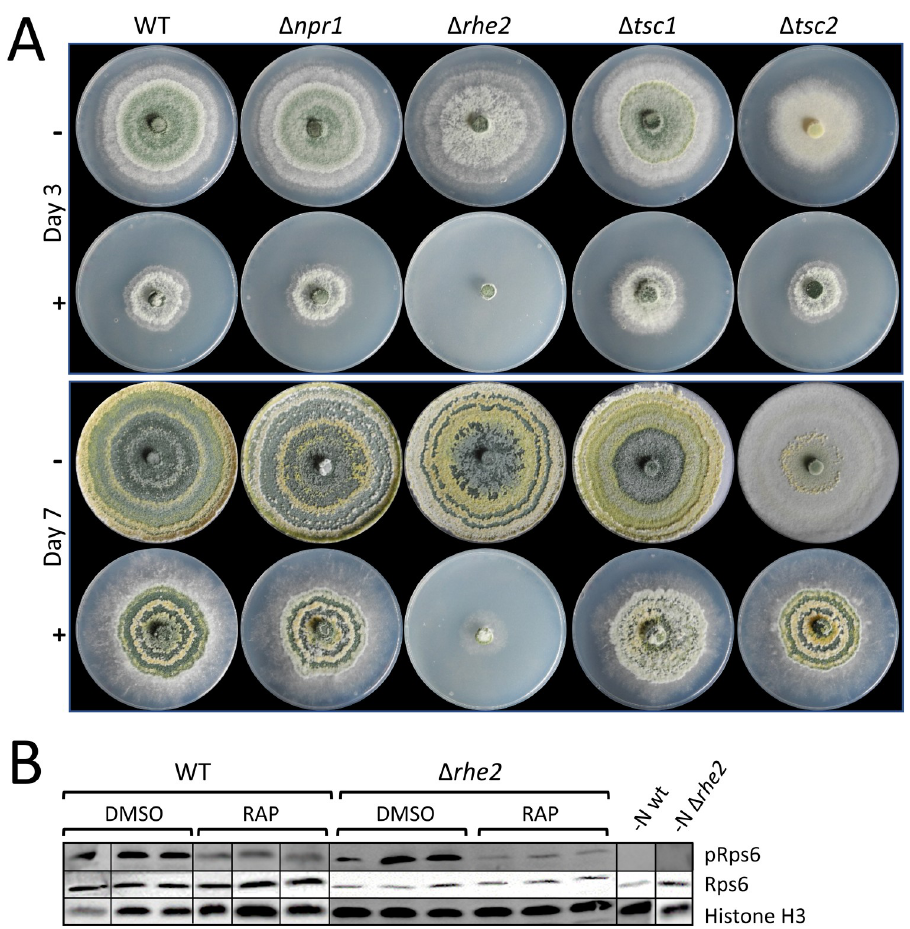
Fig 7. Effect of rapamycin on growth of T . atroviride Δ npr1 , Δ rhe2 , Δ tsc1 and Δ tsc2 mutants and phosphorylation of ribosomal protein S6. (A) Growth of T . atroviride wild type and Δ npr1 , Δ rhe2 , Δ tsc1 and Δ tsc2 mutants on minimal medium with 50 mM ammonium sulfate and 10 μ g/ml rapamycin (+). Control samples (-) were amended with equal amount of the solvent DMSO. Plates were incubated at 25˚C and pictures were taken after three and seven days. (B) Western blot analysis of ribosomal protein S6 (RPS6) phosphorylation in T . atroviride wild type and the rapamycin hypersensitive Δ rhe2 mutant after nitrogen starvation for five hours (-N) and subsequent growth in the presence (RAP) or absence (DMSO) of 20 μ g/ml rapamycin in minimal media with 50 mM ammonium sulfate for two hours (three biological replicates for both rapamycin treatment and DMSO control are shown). Samples were probed for P-RPS6, total RPS6, and the loading control histone H3 using antibodies anti-phospho-(Ser/Thr) Akt substrate, anti- Rps6, and anti-H3.